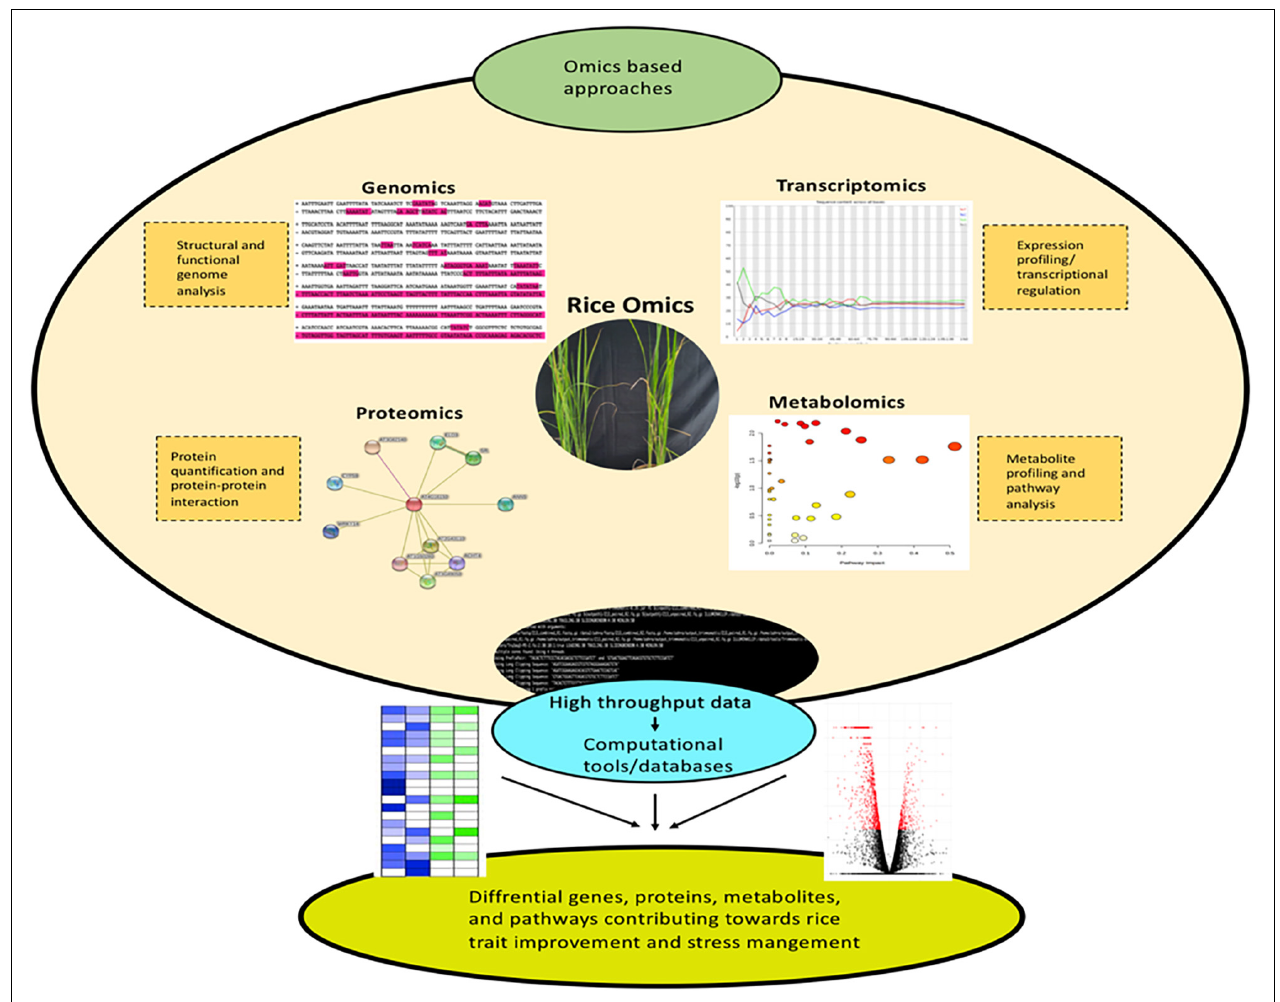
FIGURE 2 | Overview of omics techniques with respective databases and tools in rice trait improvement and stress management. Databases and tools used include: genomics-PlantCARE, transcriptomics-FASTQC, proteomics-STRING, metabolomics-MetaboAnalyst 5.0. For volcano plot R was used, while MAPMAN was used to generate the